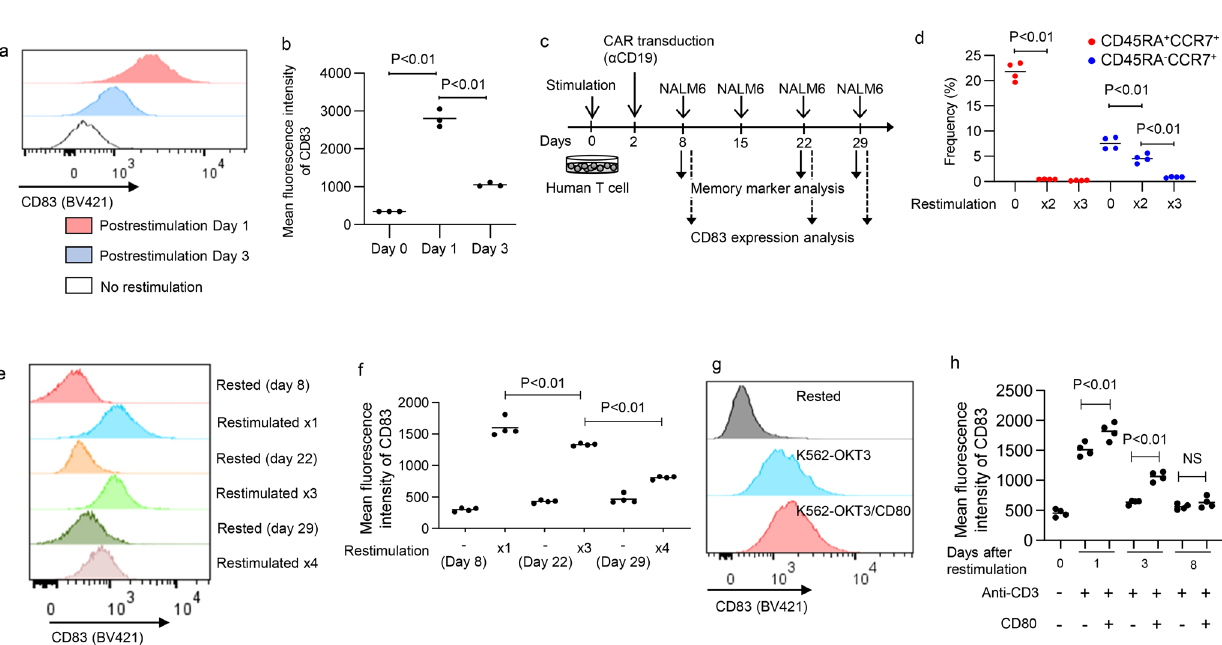
Fig. 4 CD83 upregulation upon antigen stimulation is attenuated along with terminal T cell differentiation. a , b CD19-targeting CAR-T cells were stimulated by NALM6 in vitro and analyzed for CD83 expression at the indicated time points. a Representative fl ow cytometry plots in the CD8 + CAR-T cell population. b The mean fl uorescence intensity (MFI) of CD83 is shown ( n = 3 independent cultures, ordinary one-way ANOVA with multiple comparison test). c CD19-targeting CAR-T cells were repeatedly stimulated by NALM6. d The frequency of CD45RA + / − CCR7 + memory T-cell population was analyzed at the indicated time points ( n = 4 independent cultures, ordinary one-way ANOVA with multiple comparison test). e , f CD83 expression was analyzed in the CD8 + CAR-T cell population upon repeated NALM6 stimulation. The data shown are representative fl ow cytometry plots ( e ) and the calculated CD83 MFI ( f ), ( n = 4 independent cultures, ordinary one-way ANOVA with multiple comparison test). g , h Cultured T cells were restimulated by K562-OKT3 or K562-OKT3/CD80 and analyzed for CD83 expression. Representative fl ow cytometry plots ( g ) and the CD83 MFI at days 1, 3, and 8 after restimulation are shown ( h ), ( n = 4 independent cultures, unpaired two-tailed t -test at each time point). Horizontal lines indicate mean